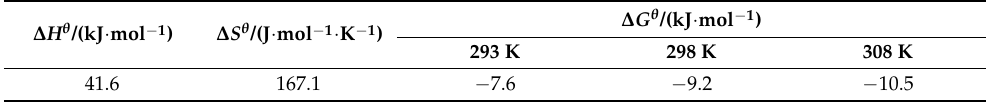
Figure 8. The fitted Cd 2+ adsorption thermodynamic curve of the carbonized ZIF−8@PAN nanofiber membrane at different temperatures. Table 1. The Cd 2+ adsorption thermodynamic parameters of the carbonized ZIF−8@PAN nanofiber membrane at different temperatures.